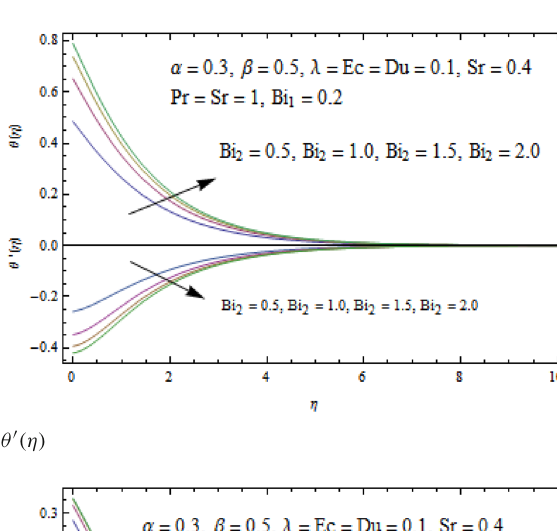
Fig. 17 Impact of Bi 2 θ(η) & θ (cid:5) (η)